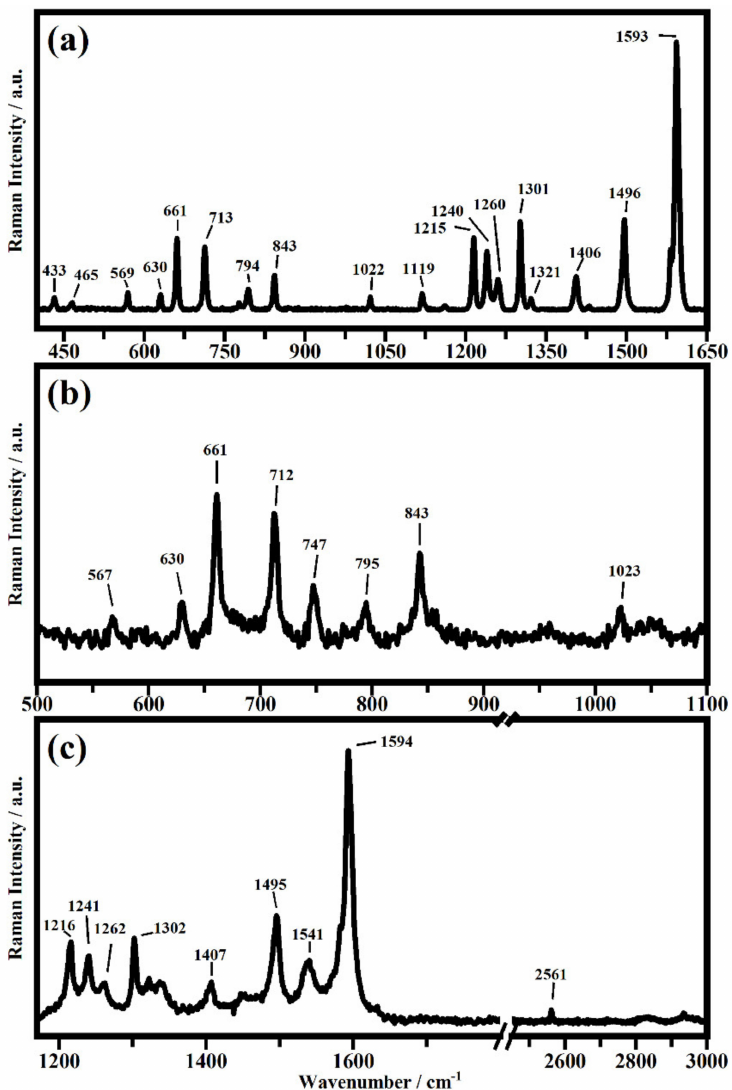
Figure 11. The first representative SERS spectrum of Bpy-SH@Au-plate in the range between 400 and 1650 cm − 1 (laser source at 633 nm) ( a ) and the second representative SERS spectra of Bpy-SH@Au- plate in the ranges between 500 and 1100 cm − 1 ( b ), 1170 and 1800 cm − 1 , 2450 and 3000 cm − 1 ( c ) (laser source at 633